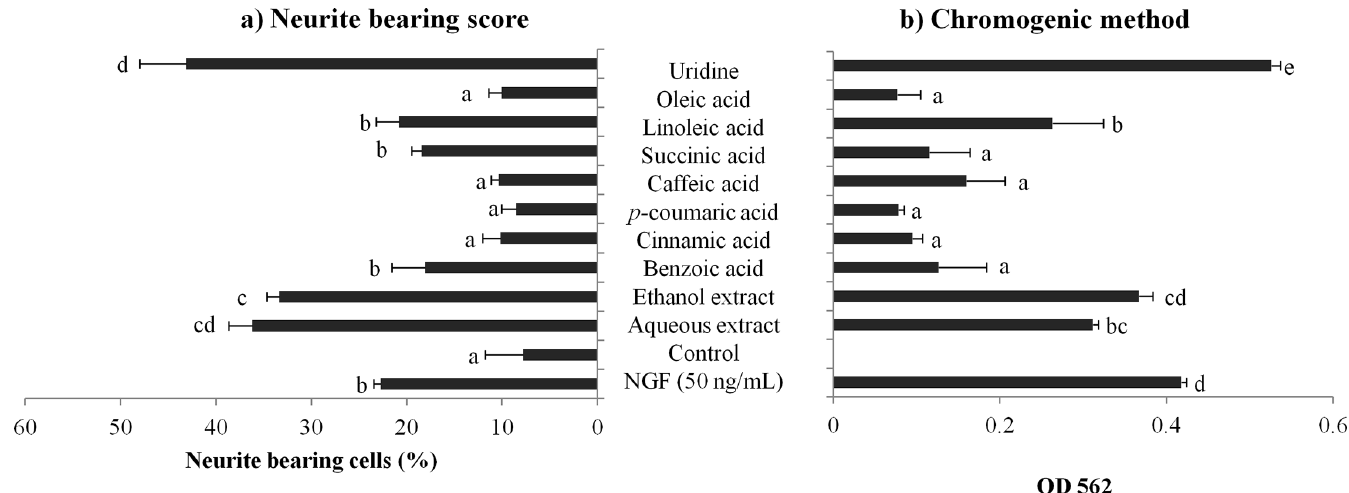
Fig 2. The effects of mushroom extracts and compounds on neurite outgrowth of differentiating N2a cells by using (a) quantification of neurite bearing cells, and (b) chromogenic method at optical density 562. NGF (50 ng/mL) was used as a positive control. Values are mean ± SD from three independent experiments. Different alphabets represent significant differences between samples ( p <